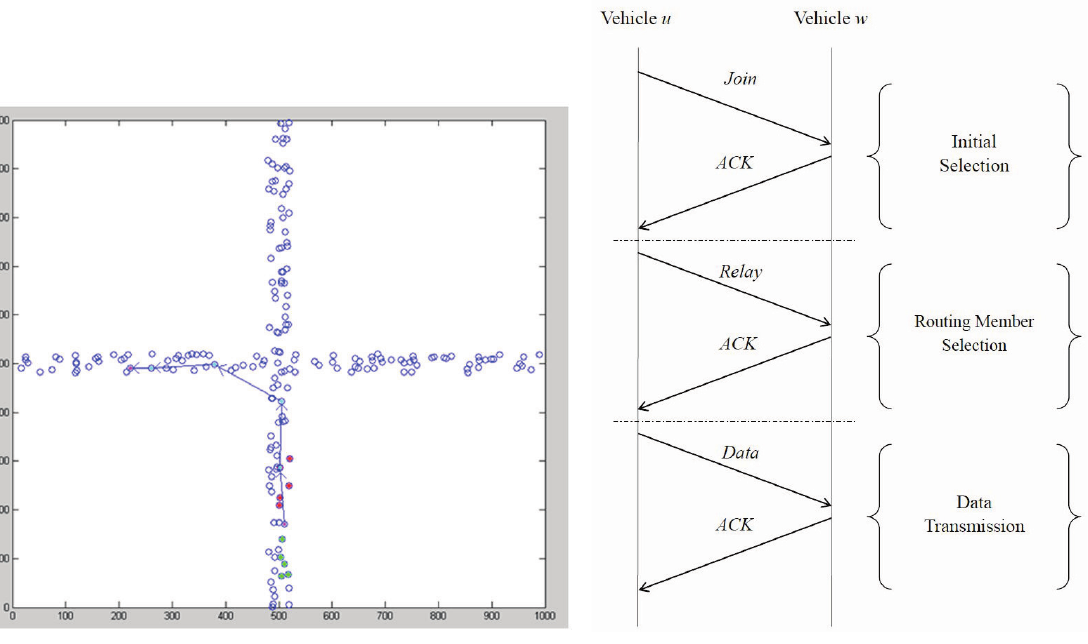
Figure 8. A typical example of the proposed HDTC scheme for information routing ( Left ); one-hop communication protocol ( Right